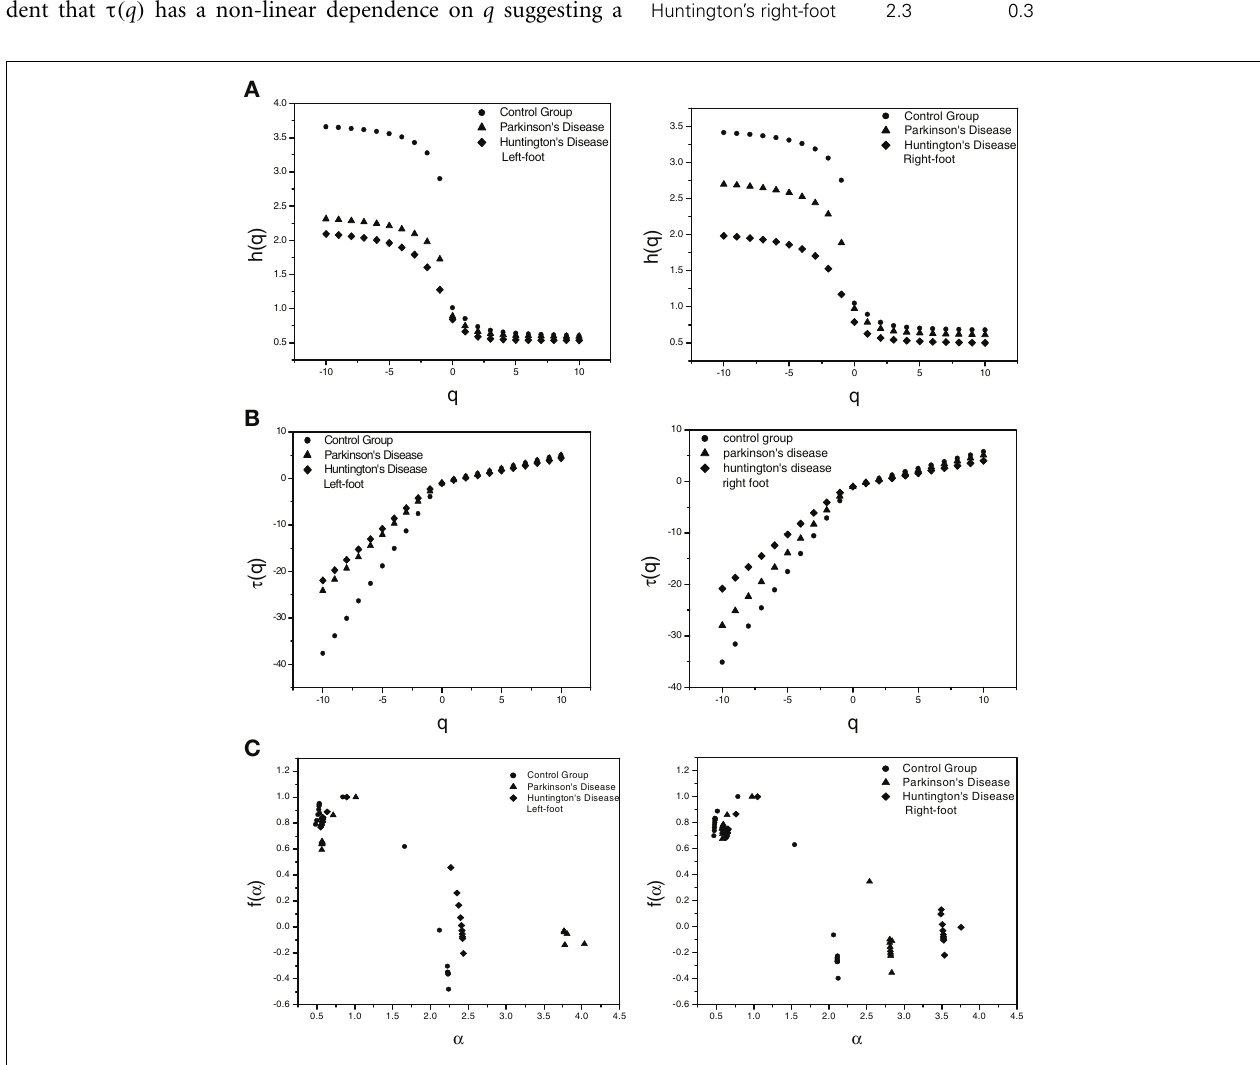
FIGURE 1 | Plot of (A) Generalized Hurst exponent h ( q ) vs. order q (B) Classical Scaling exponent (Equation 5) τ ( q ) vs. order q and (C) Dimension of subset series (Equation 6) f ( α ) vs. Singularity strength (Equation 7) α for one set each of three different cases for left-foot and for right-foot.